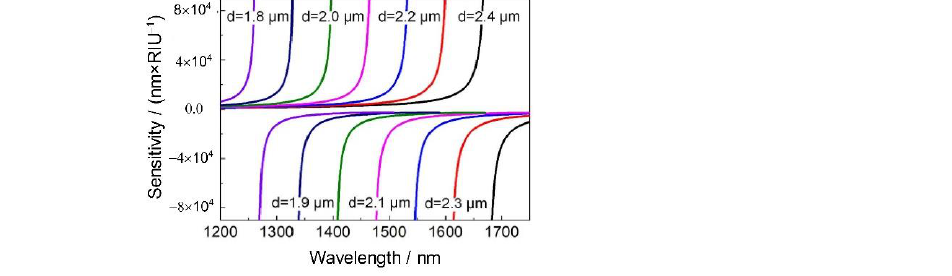
Figure 9. ( a ) Schematic of the polydimethylsiloxane (PDMS)-packaged two-mode microfiber for temperature measurement; ( b ) the transmission spectrum of the PDMS-packaged two-mode micro- fiber MZI cascaded with FBG; ( c ) cooperation of the FBG resonant dip and the interference dips (D L, 1 and D H, 1 ) lying on each side of the CWL in temperature measurement. Reprinted from Ref. [30]. Copyright (2020), with permission from Elsevier. Apart from using nonadiabatic tapers to fabricate the few-mode microfibers by ta- pering a standard SMF, other special fibers were employed to increase the sensor perfor- mance and redshift the cutoff wavelength of the high-order mode in the microfiber. In 2020, Wang et al. [31] proposed a CWL-existed in-line MZI by tapering a ring-core two- mode fiber. Quasi-adiabatic transition tapers were fabricated to provide HE 11 and HE 21 modes with continuous mode evolutions to the microfiber section. The two modes launched into the fiber were collected at the fiber output. A CWL was observed when the